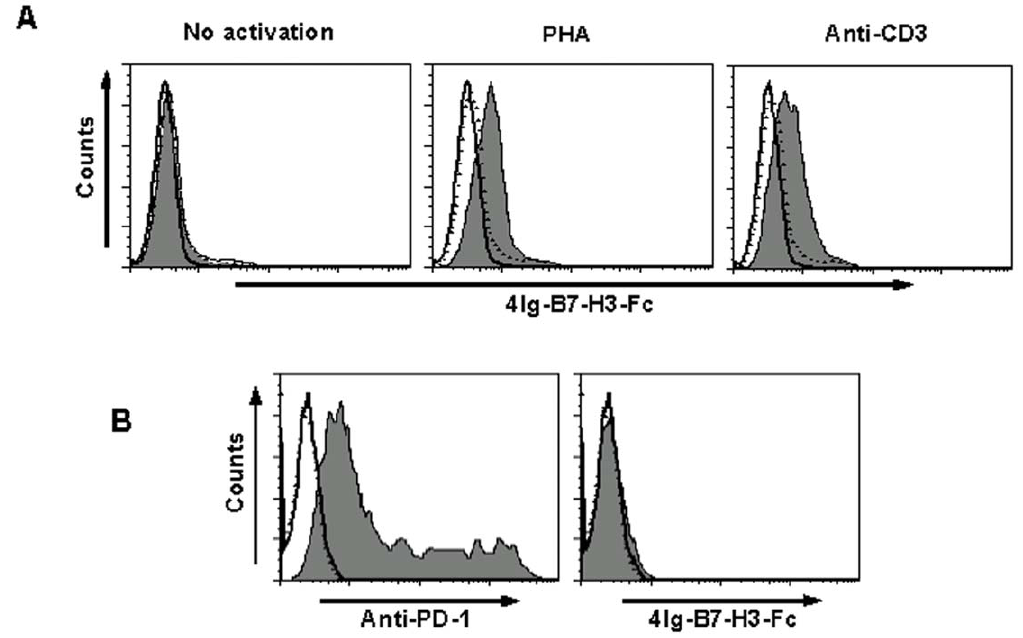
Figure 3. Analysis of a putative receptor of porcine 4Ig-B7-H3. A, Binding of porcine 4Ig-B7-H3-Fc to T cells. T cells treated in different conditions were stained with a combination of anti-CD3 mAb with Fc (solid line histogram) or isotypic Ab (dotted line histogram) or 4Ig-B7-H3-Fc (filled histogram). Left plot: T cells in PBMC were not activated. Middle plot: T cells in primary PBMCs were stimulated with 5 m g/ml of PHA for 24 h. Right plot: T cells in primary PBMCs were stimulated with 1 m g/ml of anti-porcine CD3 mAb coated on the 96-well plate for 48 h. B, PD-1 gene was transfected into 293 T cells. PD-1 expressed on the 293 T cells was stained with anti-PD-1 mAb (left, filled histogram) or 4Ig-B7-H3-Fc protein (right, filled histogram) or Fc (solid line histogram) or isotypic Ab (dotted line histogram) 24 hours later.